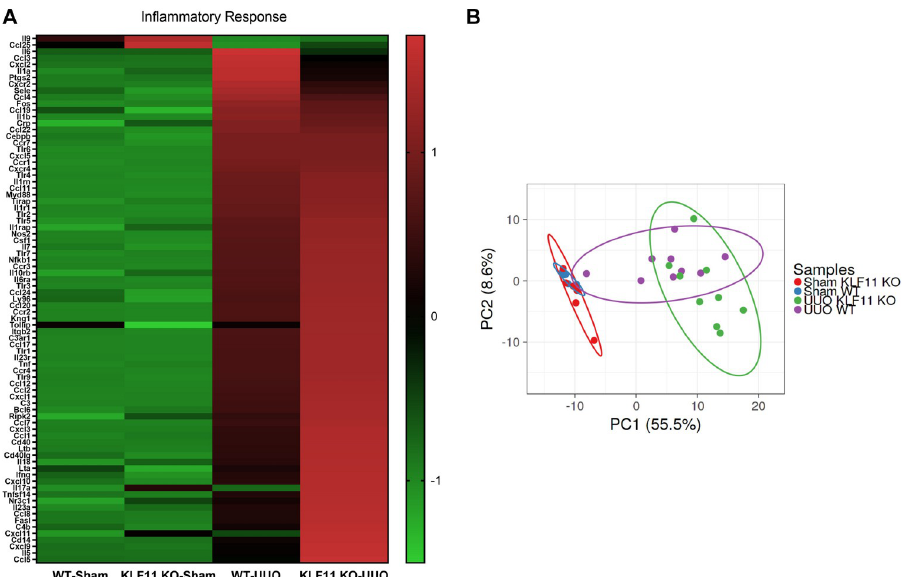
Fig 7. Heatmap of the differential gene expression of the inflammatory response. Gene expression of the Inflammatory response for WT-Sham, WT-UUO, KLF11 KO-Sham, KLF11 KO-UUO was measured, compared, and plotted in a Heatmap (A). Color scale shows high and low expressions as red and green, respectively. (B) PCA plot. 55.5% (PC1) and 8.6% (PC2) of the total variance (n = 33 data points). SVD with imputation is used to calculate principal components. X and Y axis show principal component 1 (PC1) and principal component 2 (PC2). Prediction ellipses are such that with probability 0.95, a new observation from the same group will fall inside the ellipse. Ellipses and shapes show clustering of the samples. Sham WT (n = 8), UUO WT (n = 9), Sham KLF11 KO (n = 6), UUO KLF11 KO (n = 9).